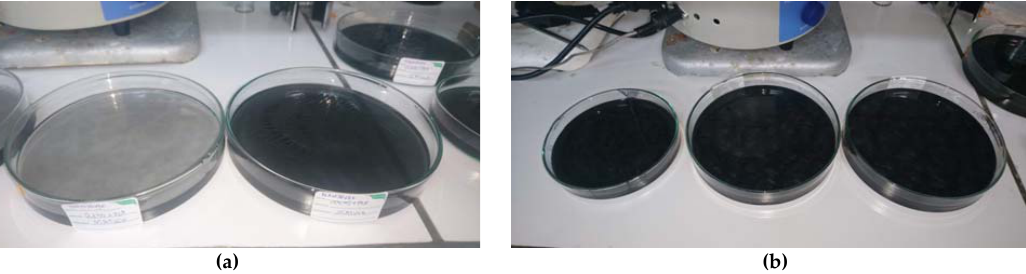
Figure 3. Suspension of PLA and CNTs ( a ) and suspension of PLA and GNP ( b ).